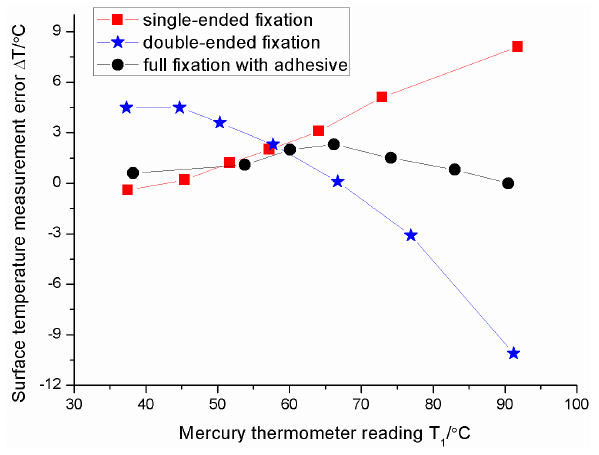
Figure 9. Surface temperature measurement errors of sensor under three different types of installation.